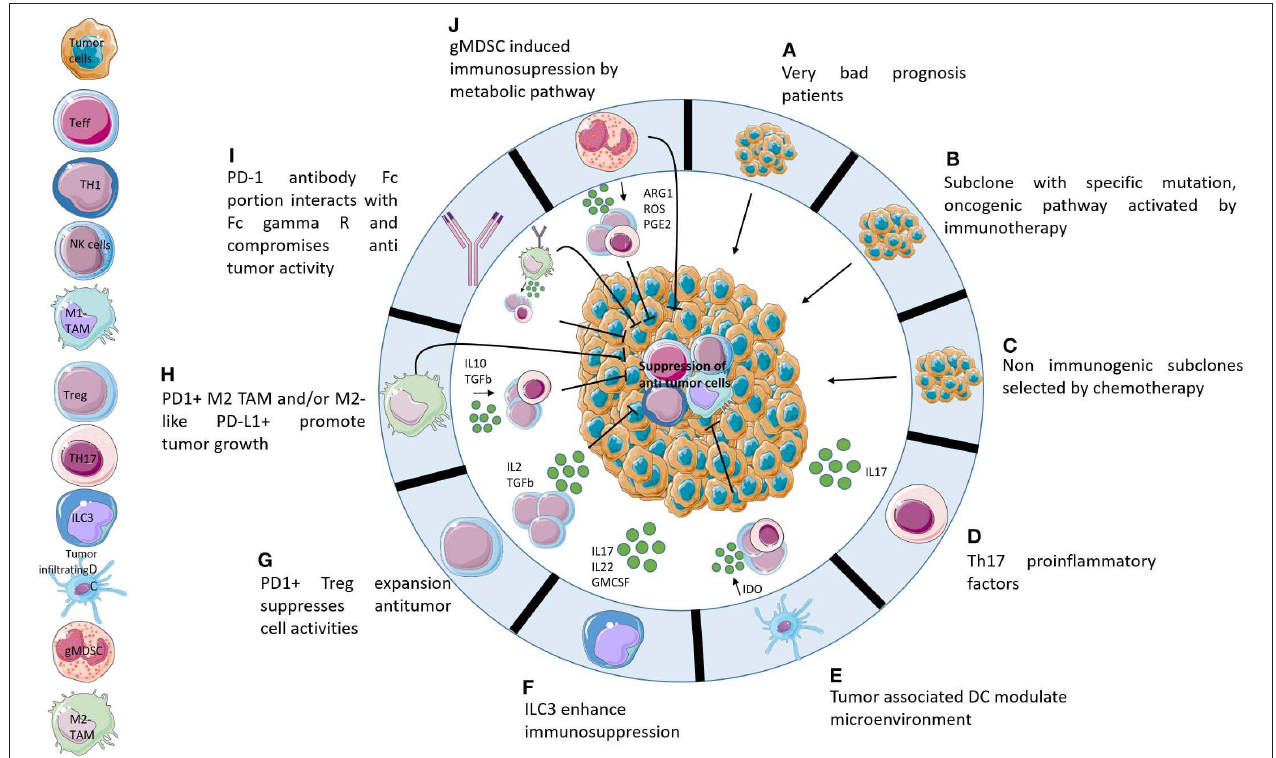
FIGURE 1 | Potential hypotheses explaining hyperprogression. Ten potential mechanisms that may be responsible for hyperprogression following administration of immunotherapies. (A) HPD is not caused by immunotherapies but it is a consequence of adverse prognostic profiles. (B) Activation of oncogenic pathways caused by PD-1/PD-L1 axis blockade. (C) Non-immunogenic subclones resistant to chemotherapy develop very quickly following the cessation of chemotherapy. (D) The TH17 axis causes increased inflammation following immunotherapy administration. (E) Tumor associated DCs contribute to immunosuppression of the microenvironment after blocking of the PD-1/PD-L1 axis. (F) PD1/PD-L1 blockade activates ILC3 which enhances immunosuppression by protumoral interleukins. (G) Blocking of PD-1 activates Treg PD1 + which induces suppression of Teff. (H) Activation, by PD-1/PD-L1 axis blocking, of M2-like PD-L1 + cells which promote tumor growth directly and indirectly by expansion of protumoral cells. (I) Fc receptor of anti-PD-1 enhances tumor growth by recruitment of M2-like cells. (J) gMDSC following immunotherapies induces immunosuppression by release metabolites which suppress antitumor cells.